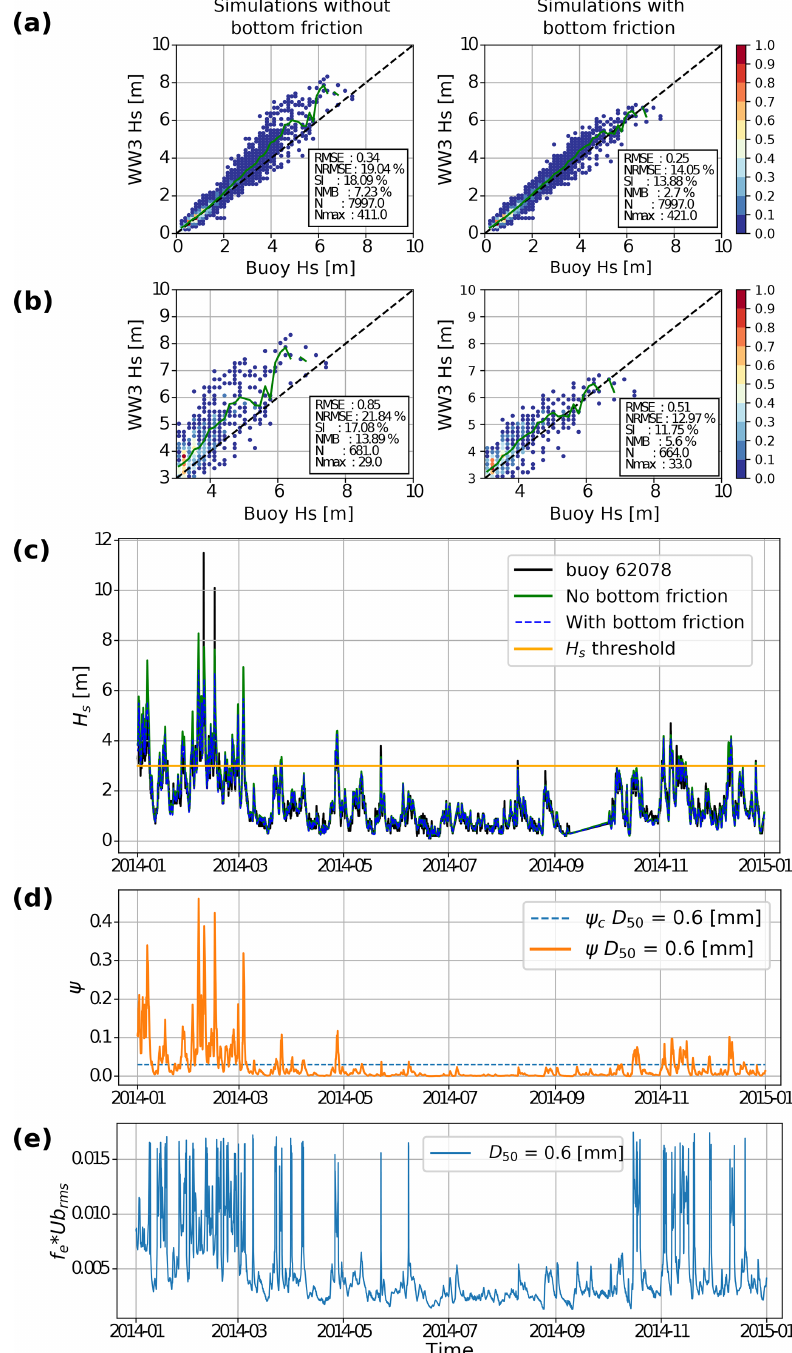
Figure 15. Bottom friction effects at buoy 62078 (year 2014). Performance analysis using (a) complete time series and (b) extreme events ( H s > 3 . 5m). (c) H s time series for cases with and without SHOWEX parameterization. Time series of (d) Shields number ψ and (e) dissipation term f e u b,rms . In (a) and (b) green line shows the modeled averaged values at each 0.15m wave height bin. Color bars represent the wave height frequency of occurrence normalized by the total number of analyzed data N . Time series in (d) and (e) computed with WW3’s frequency spectrum following Eqs. (6) to (13). D 50 taken from bottom sediment map (Fig. 2). Blue dashed line in (d) represents the critical Shields